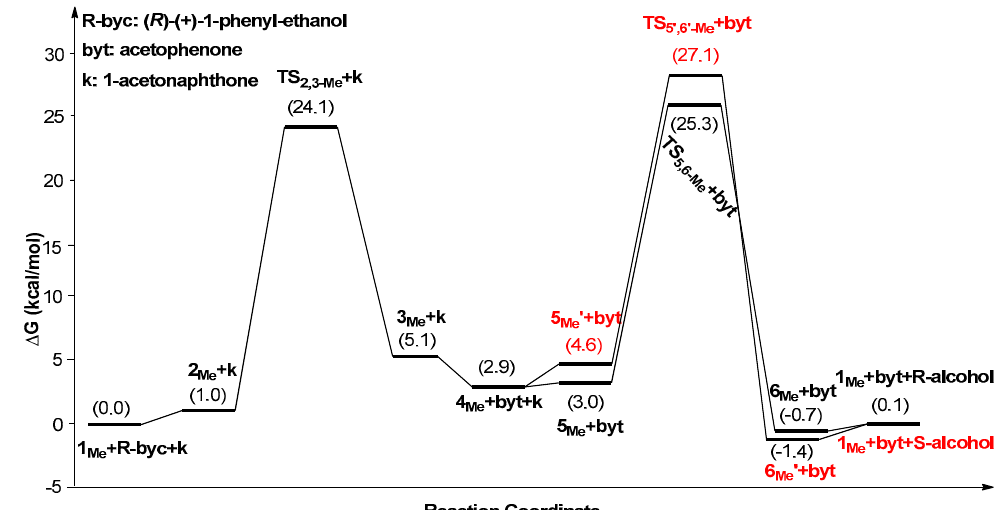
Figure 4. Relative free energy profile for the asymmetric transfer hydrogenation catalyzed by 1 Me .